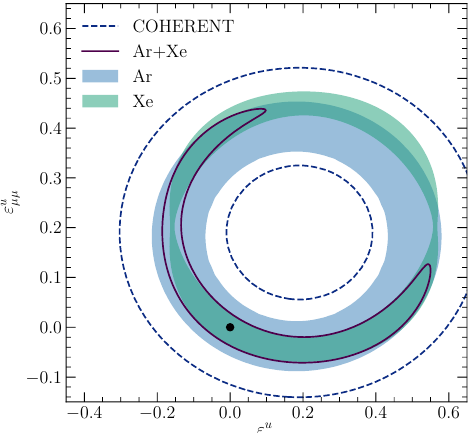
Figure 14 . Expected allowed regions in the ( (cid:15) u;V ; (cid:15) u;V ) plane at the 90% C.L. for 2 d.o.f, for the ee (cid:22)(cid:22) gas TPC detector operating with two di(cid:11)erent nuclei (separate runs, each of them for 3 years), as well as for a con(cid:12)guration where the detector is (cid:12)lled with each of the two gases during half of the total data taking period (1.5 years running with 132 Xe, 1.5 years with 40 Ar). In all cases, the simulated data has been generated for the SM and the results are then (cid:12)tted assuming NSI. For simplicity, the values for the rest of NSI parameters not shown in this (cid:12)gure have been set to